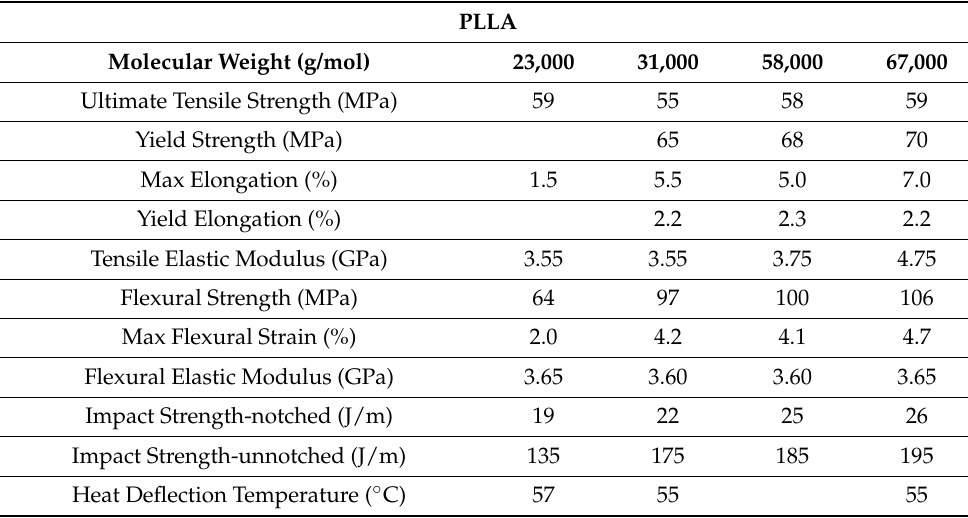
Figure 1. Stereoisomers of lactic acid. Table 8. Mechanical properties of PLA variants with varying molecular weights [58] .